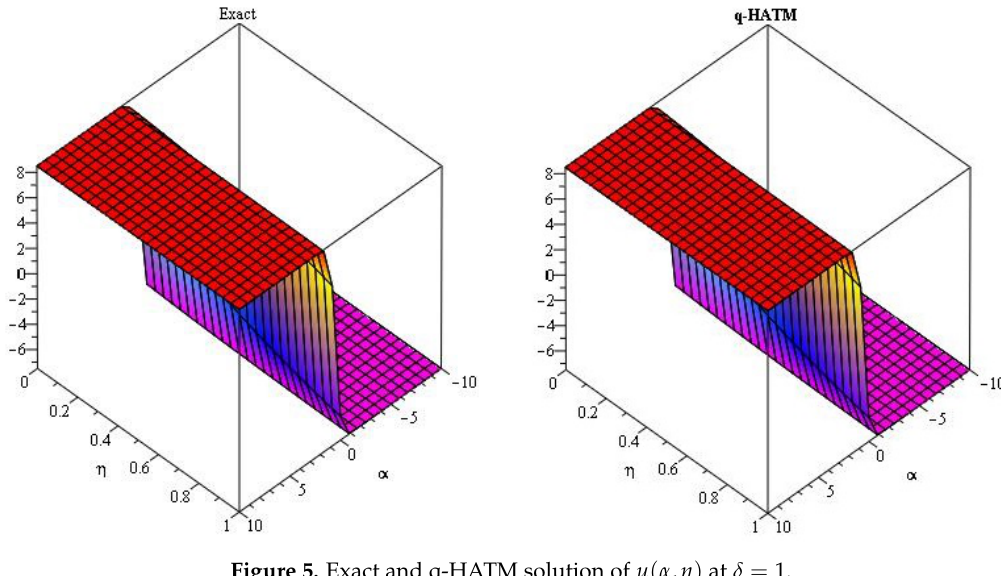
Figure 5. Exact and q-HATM solution of µ ( α , η ) at δ = 1.